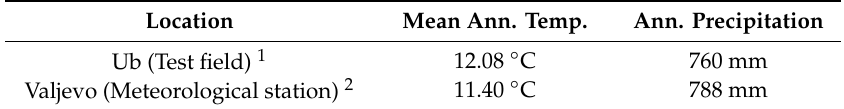
Table 1. Climatic conditions—Ub and Valjevo. Location Mean Ann. Temp.